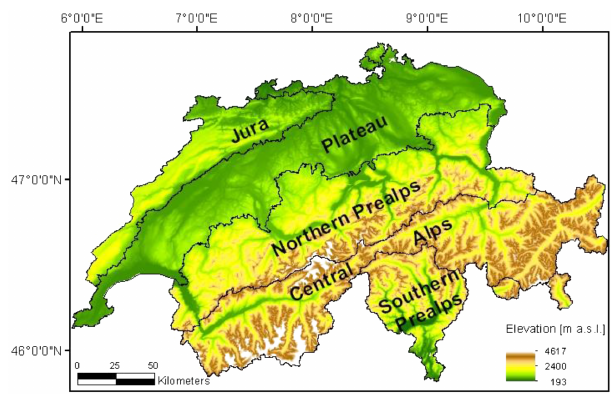
Figure 1. Digital elevation model and biogeographical regions of